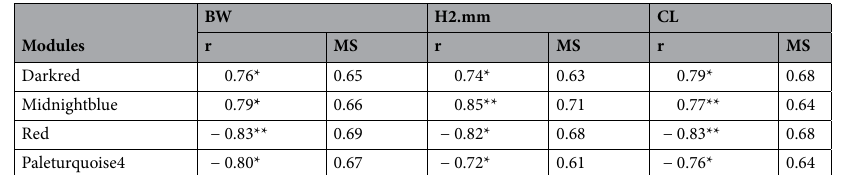
Table 1. Pearson’s correlation values (r) between the modules most significantly associated with the macro- trait and phenotypes belonging to the macro-trait: breast weight (BW), middle height (H2.mm), and cooking loss (CL). Also, significance values (MS) of each selected module are reported. *P < 0.01; **P <